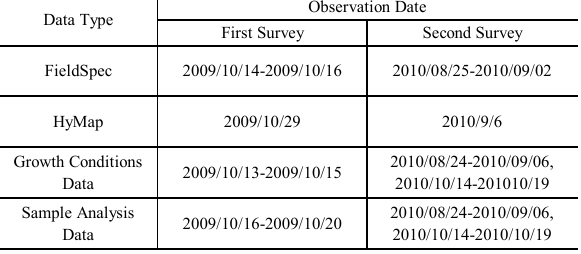
Table 1: Data Used for this Study and Observation Date